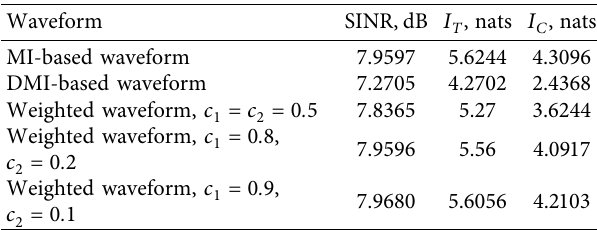
Figure 9, all weighted MI- and DMI-based waveforms with different weights perform better than DMI-based waveform.